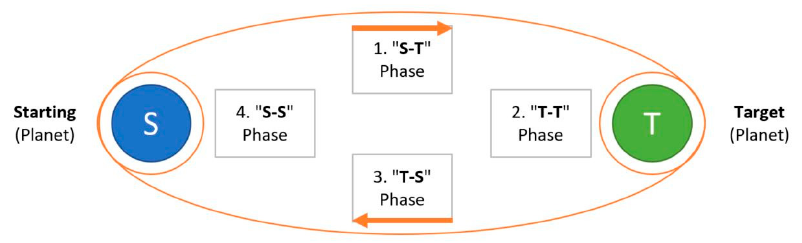
Figure 1. The generic Stopover Cycler between a Starting planet and a Target planet and its four phases: “ in the first one, referred to as S-T phase, the spacecraft is transferred from the starting to the target planet. The spacecraft then orbits around the target and waits for the next opportunity to return back. This waiting time at the target is denoted by T-T phase, whereas the return voyage towards the starting planet is called T-S phase. The stopover cycler ends with a waiting S-S phase at the starting planet, whose duration is equal to the time length necessary for the planets to return in the same relative configuration they occupied at time t0 ” [3].